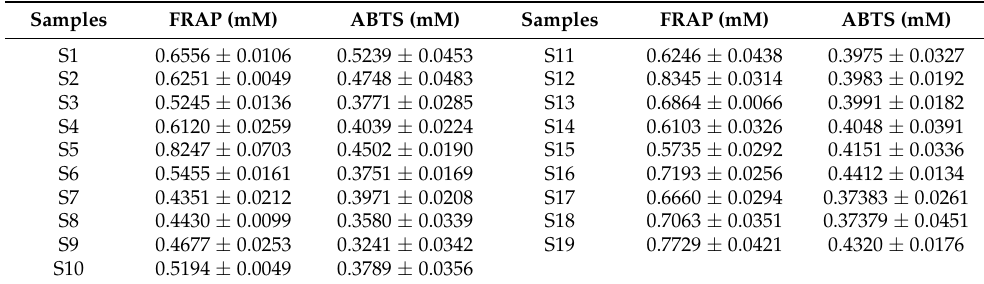
Table 2. Total antioxidant capacity of 19 batches of dandelion.